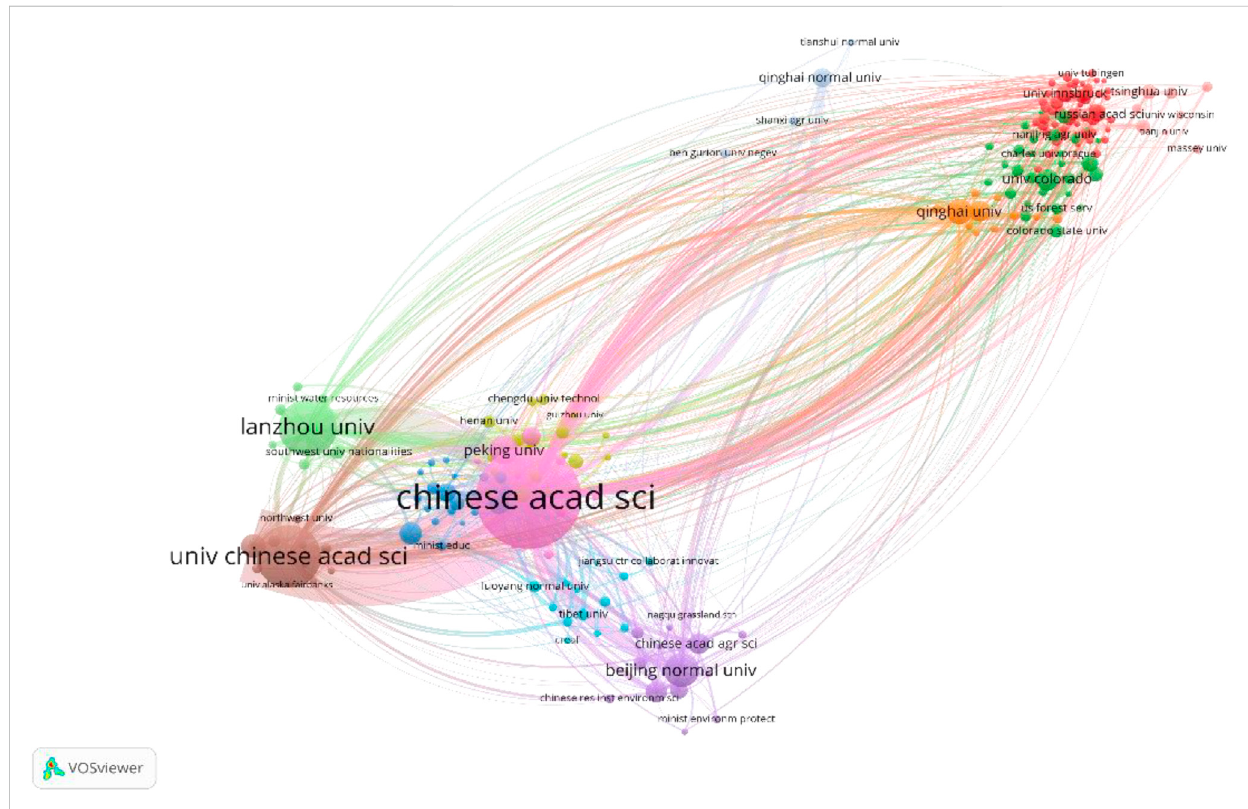
FIGURE 11 Institutional network analysis of co-cited papers.